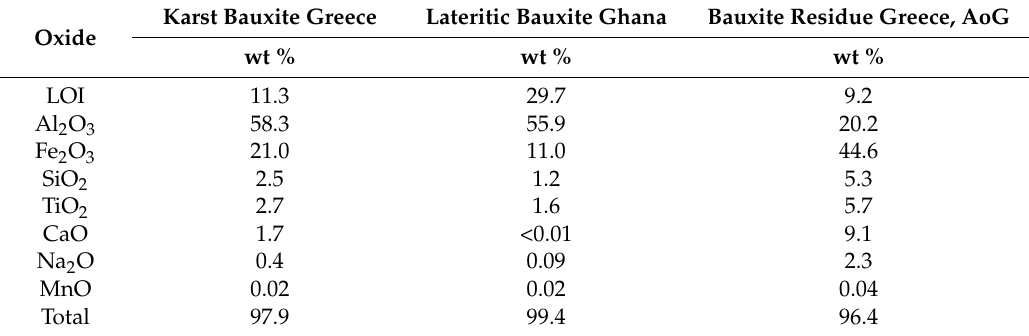
Table 2. Major oxide composition of the samples.